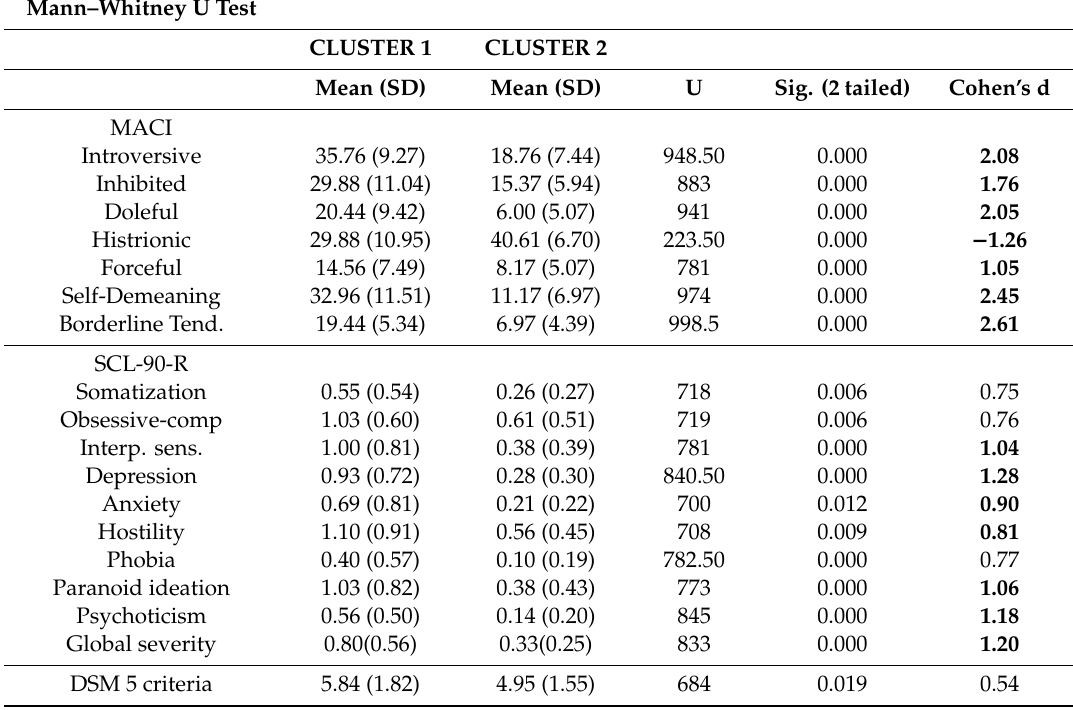
Table 3. Mann–Whitney U-test for the MACI, Symptom CheckList-90 items-Revised (SCL-90-R), and DSM 5 criteria mean scores (cluster 1 n = 24, cluster 2 n =